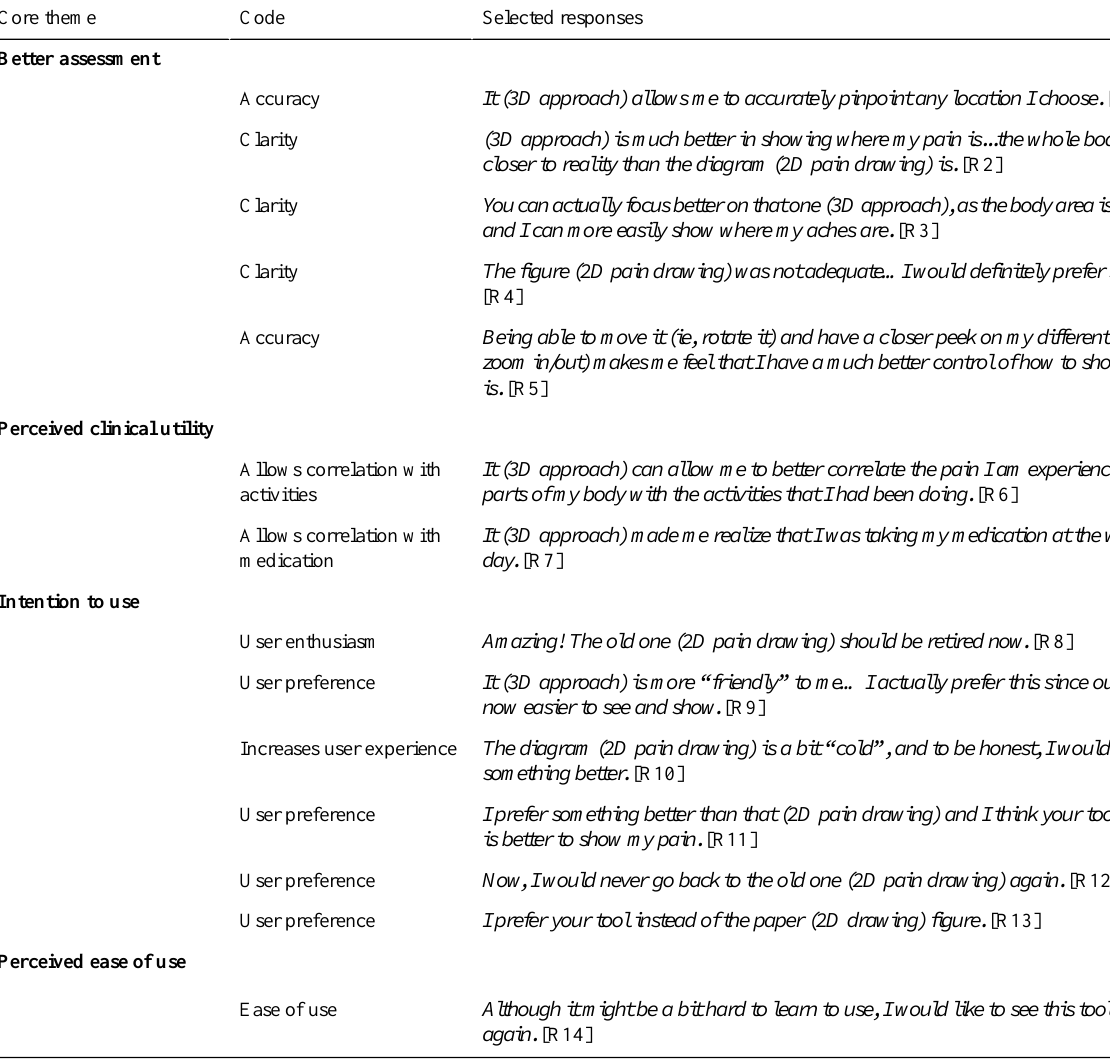
Table 1. Selected participant responses and core